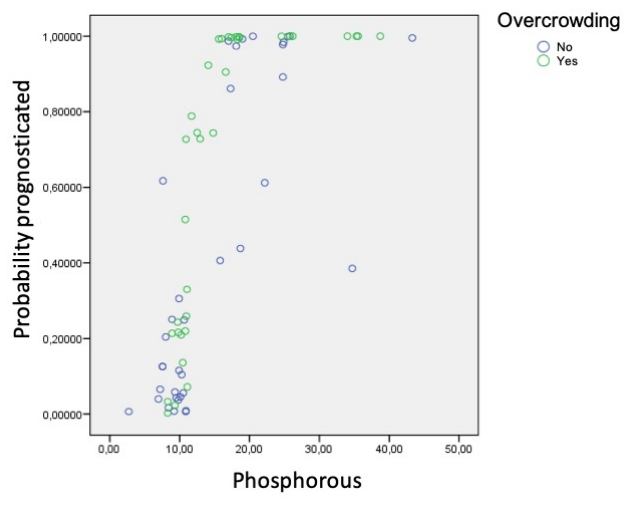
Figure 6. Bacteria distribution by group.